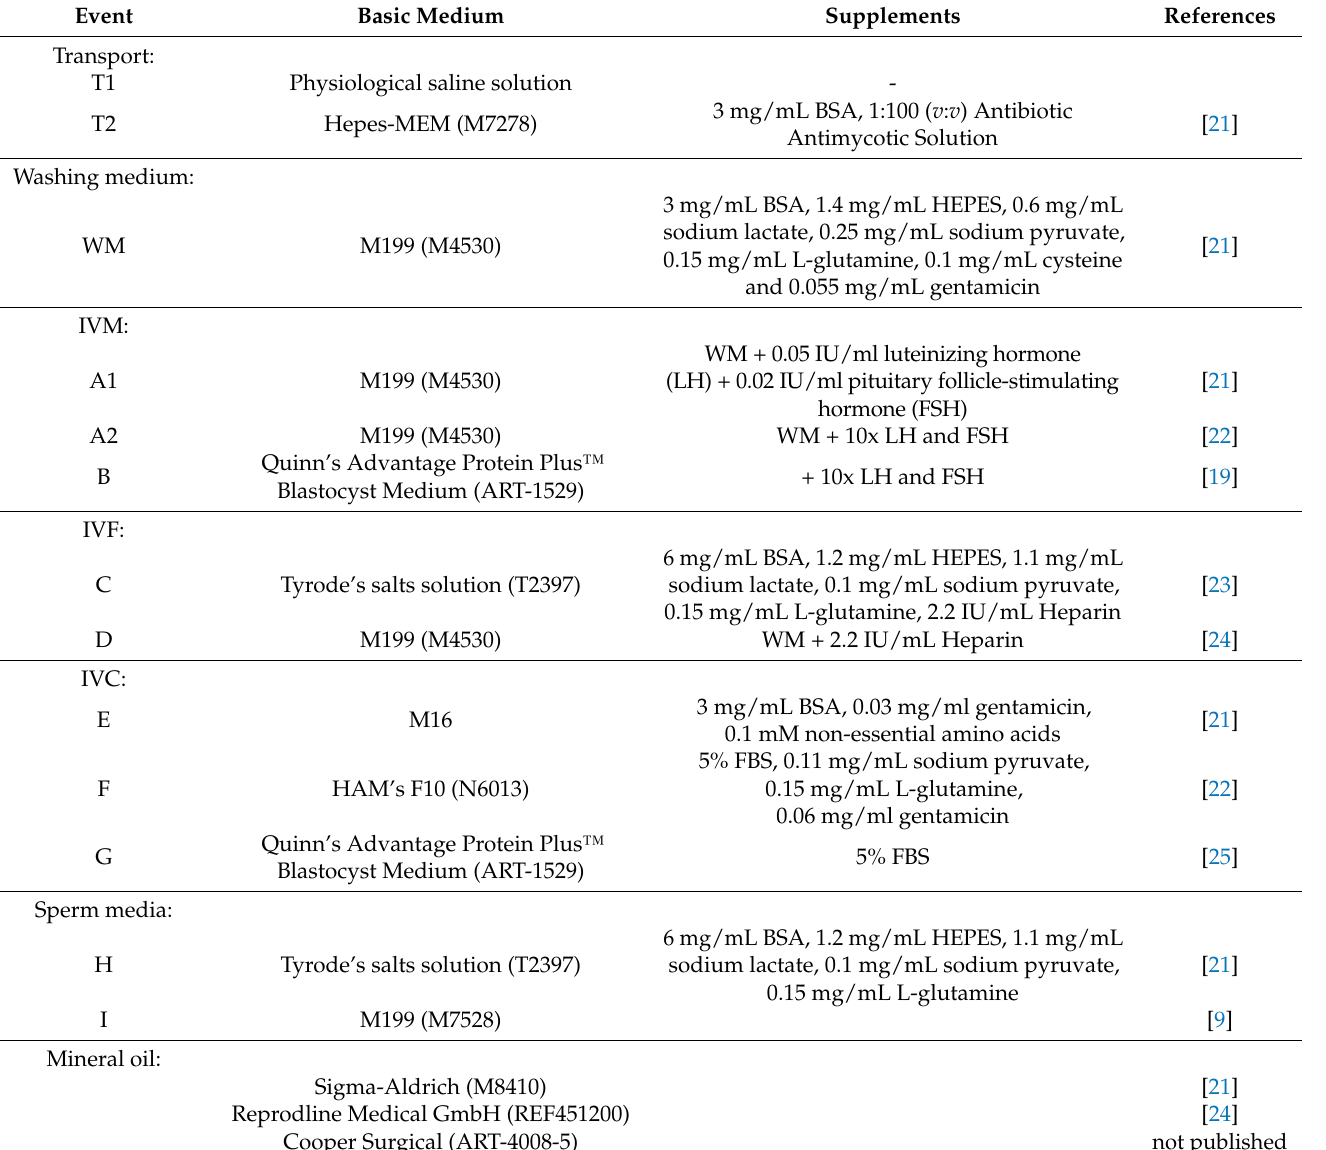
listed in Table 2. In IVF experiments, maturation failure was only detectable after IVF and final fixation of oocytes; therefore, all utilized media were noted. Table 2. Overview of media compositions utilized in this